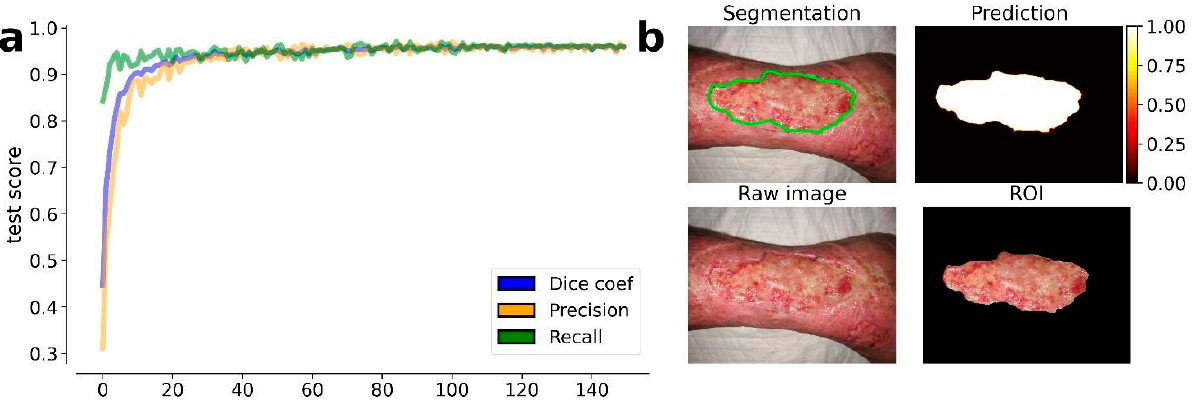
Figure 1. Results obtained by the trained U-Net model at the 4th round of training. ( a ) Evolution of the average metrics (dice coefficient, precision, and recall) during the training epochs (150). The metric values are estimated on the test set, i.e., the 10% of available images, which were excluded from the training set. On the top left image is the resulting segmentation. ( b ) On the top right image is the predicted segmentation mask. On the bottom left image is the raw (input) image. On the bottom right image is the resulting ROI of the wound area.